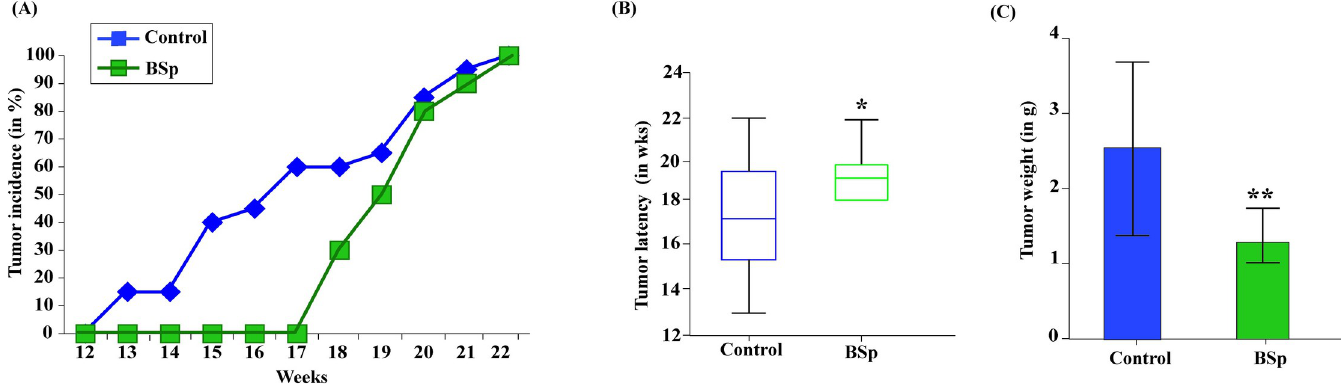
Fig 2. Tumor growth in female progenies with maternal dietary administration of BSp. SV40 dams were administered with regular Control diet or customized 26% BSp diet throughout the lifespan. Female offspring mice were weaned at 4 wks of age and maintained on Control diet and monitored for mammary tumor development. (A) Tumor incidence measured by percentage over the whole population. (B) Median tumor latency in the offspring. (C) Average tumor weight among the dietary treatment group. Columns, mean; bars, standard deviation; � p value < 0.05, �� p value < 0.01, significantly different from the Control group.